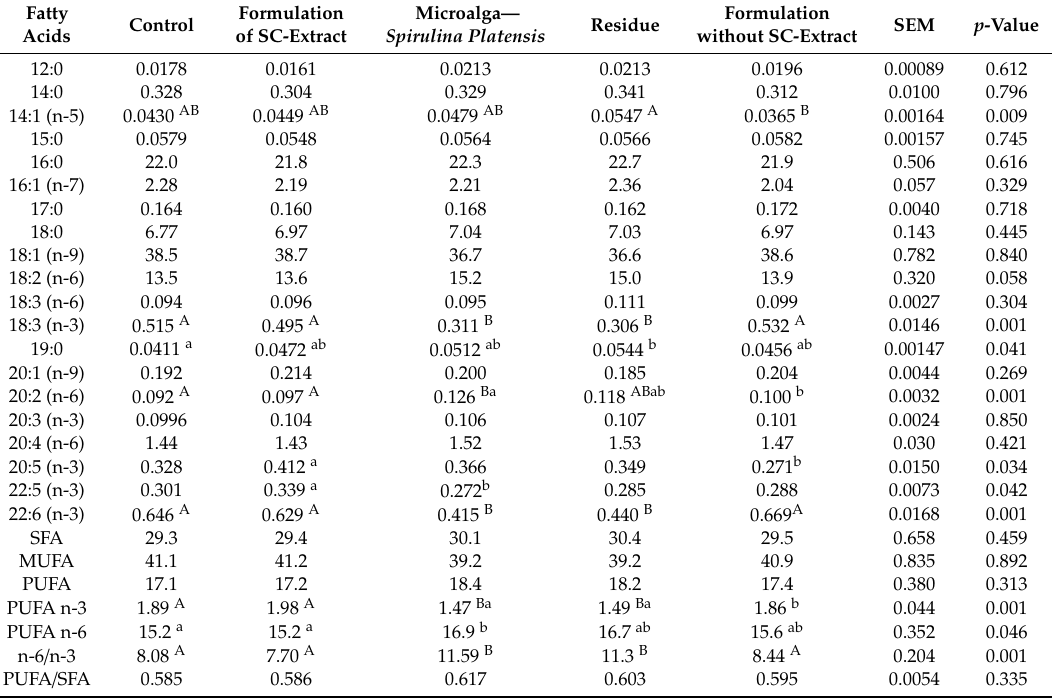
Table 7. The content of FAs in the eggs (% weight of FAs in the sample) after 90 days of the experiment. Fatty